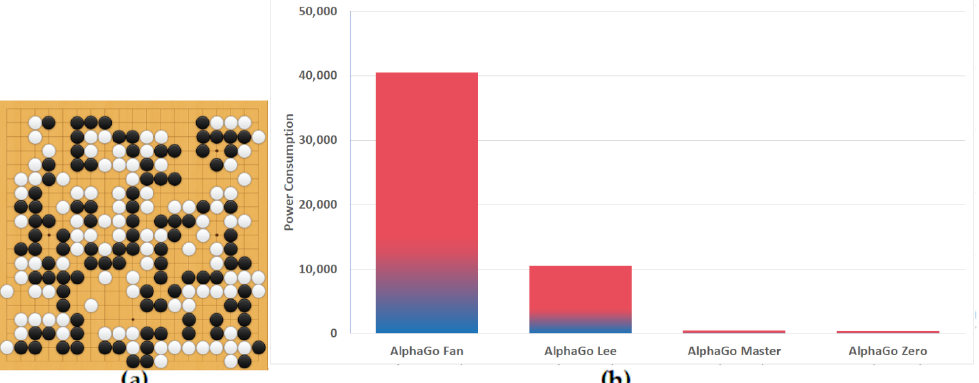
Figure 11. ( a ) This is the fourth game of Sedol vs. AlphaGo, where Sedol won. This was the only win Sedol achieved, with the final score of the series Alpha Go 4–Sedol 1. ( b ) This is the computational consumption of the AlphaGo Zero vs. all of the other AlphaGo implementations. AlphaGo Fan, the first in the graph, needed 156 GPUs in order to run, whereas Alpha Zero only utilized 4